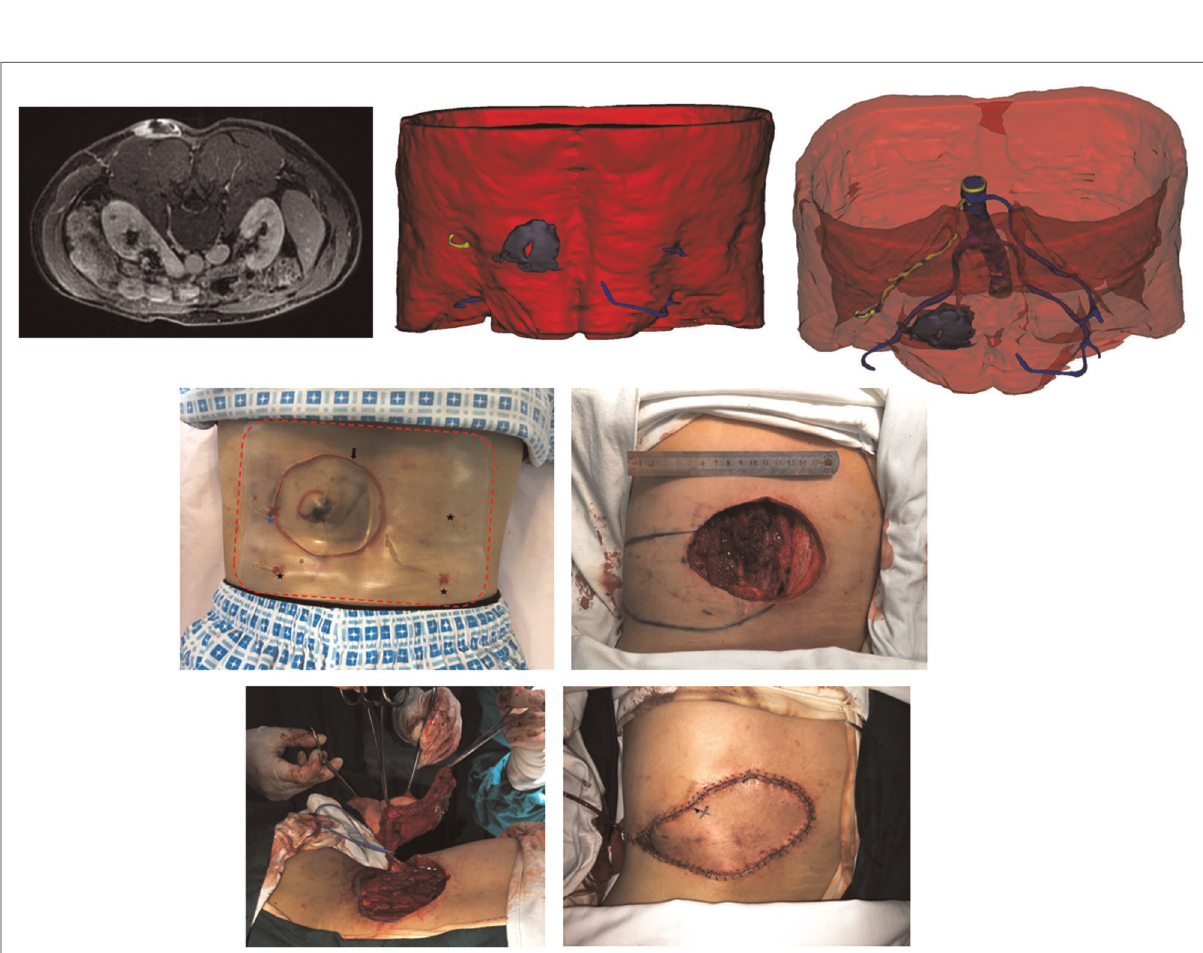
FIGURE 4 (Above, left) preoperative MRI showing the tumor in fi ltrating the underlying muscle and adjacent perforator. (Above, middle) 3DR showing the surgical anatomy involving the tumor, underlying muscle, and four perforators. The PPPF was planned based on the yellow perforator. (Above, right) Transparent image showing perforators and main source arteries. (Center, left) Skin incision (black arrow) at 2 cm distance from the tumor boundary and the projection of four perforators according to the surgical guide templates (red dotted line) preoperatively. The blue star represents the perferred yellow perforator, and the three black stars represent the remaining blue perforators. (Center, right) Wound after en bloc tumor resection and fl ap design. The circle represents the piercing site of the superiorly left perforator. The star represents the piercing site of the inferiorly left perforator. (Below, left) harvesting the fl ap. (Below, right) rotation of the fl ap for 130° to cover the wound and direct closure of the donor